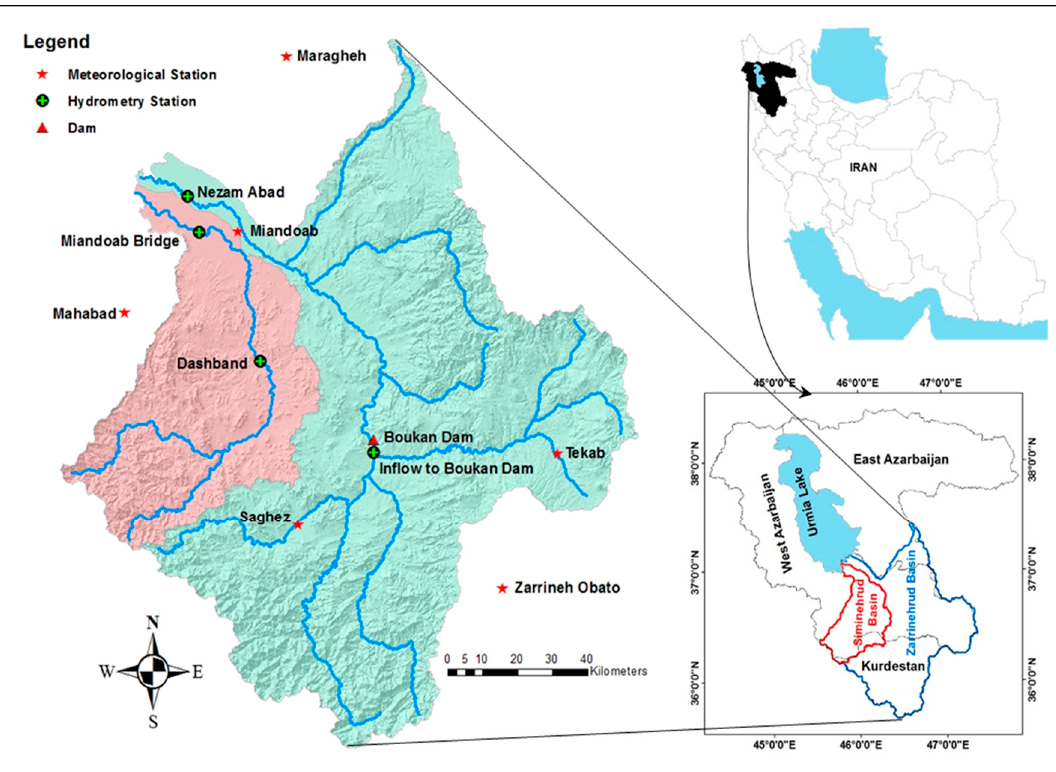
Figure 1. The map of the studied area.